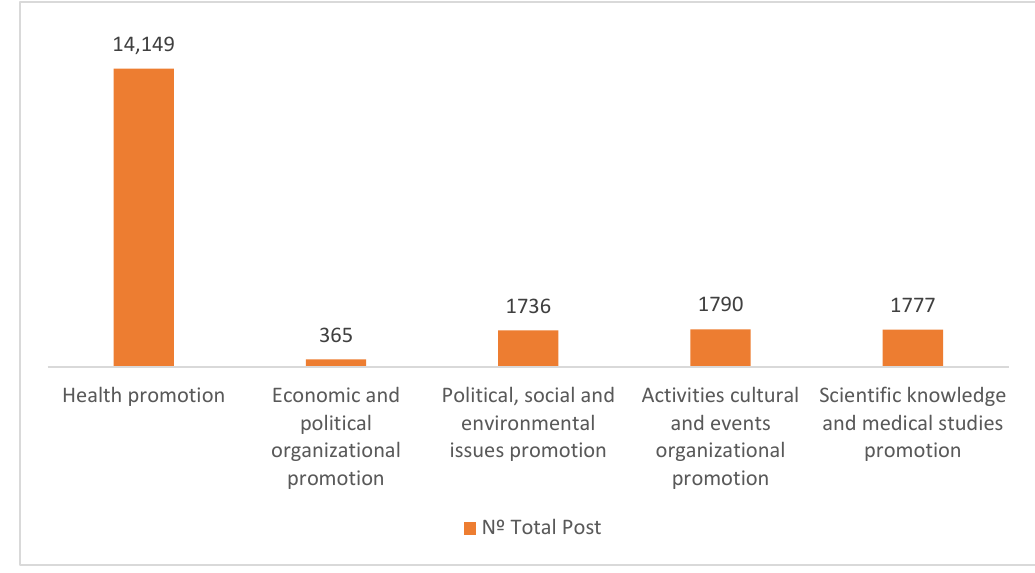
Figure 3. Number of posts by content type.